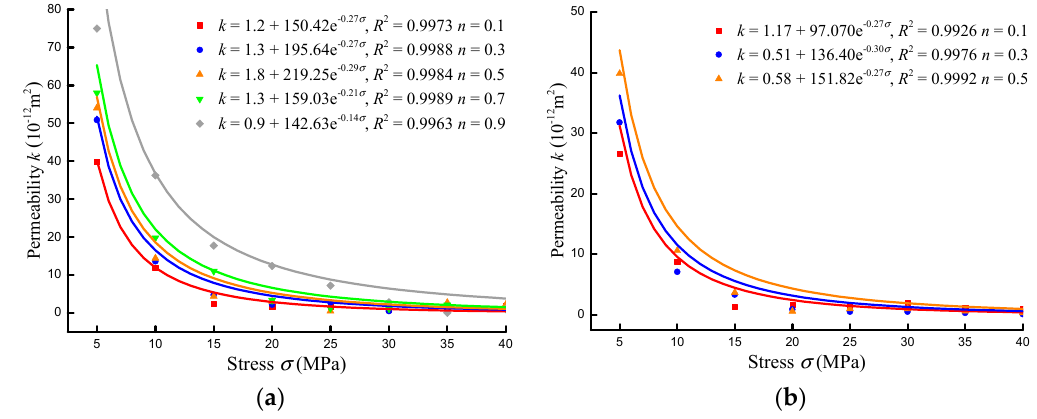
Figure 6. Permeability of broken gangue with different compressive stress: ( a ) continuous grading; and ( b ) discontinuous grading.